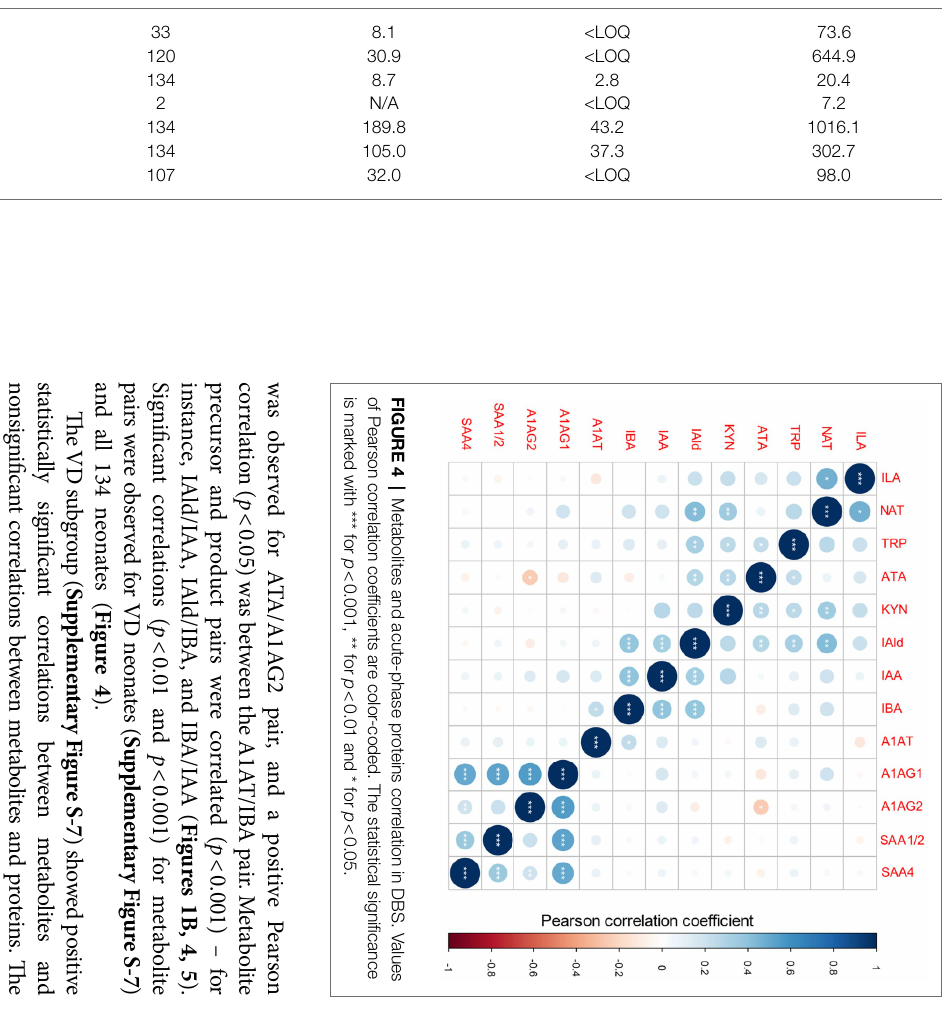
The lowest The highest (mg/L of blood) concentration (mg/L of concentration (mg/L of blood)